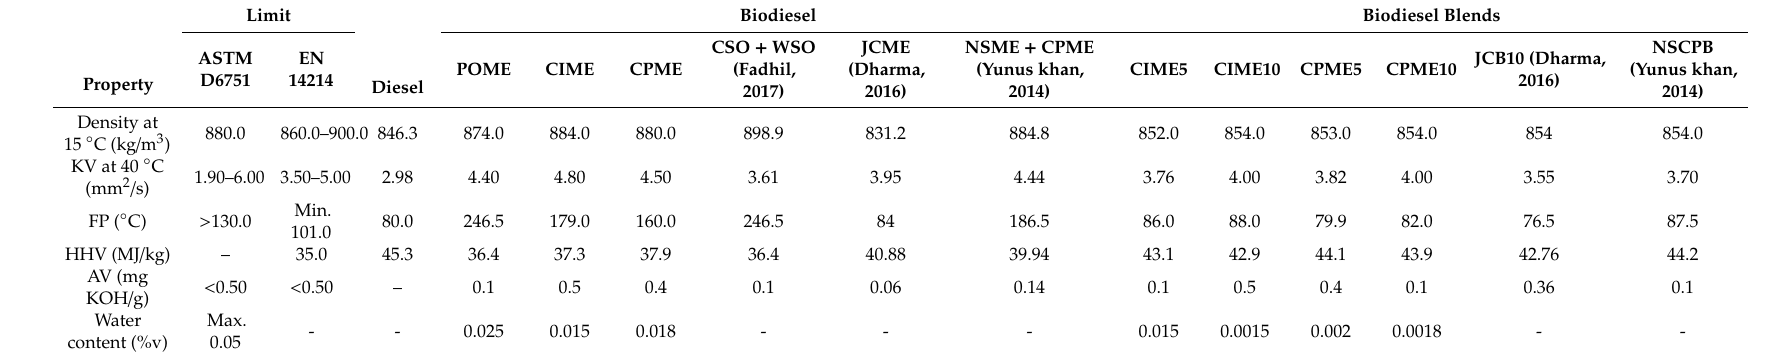
Table 3. Comparative physicochemical properties of the fuel sample